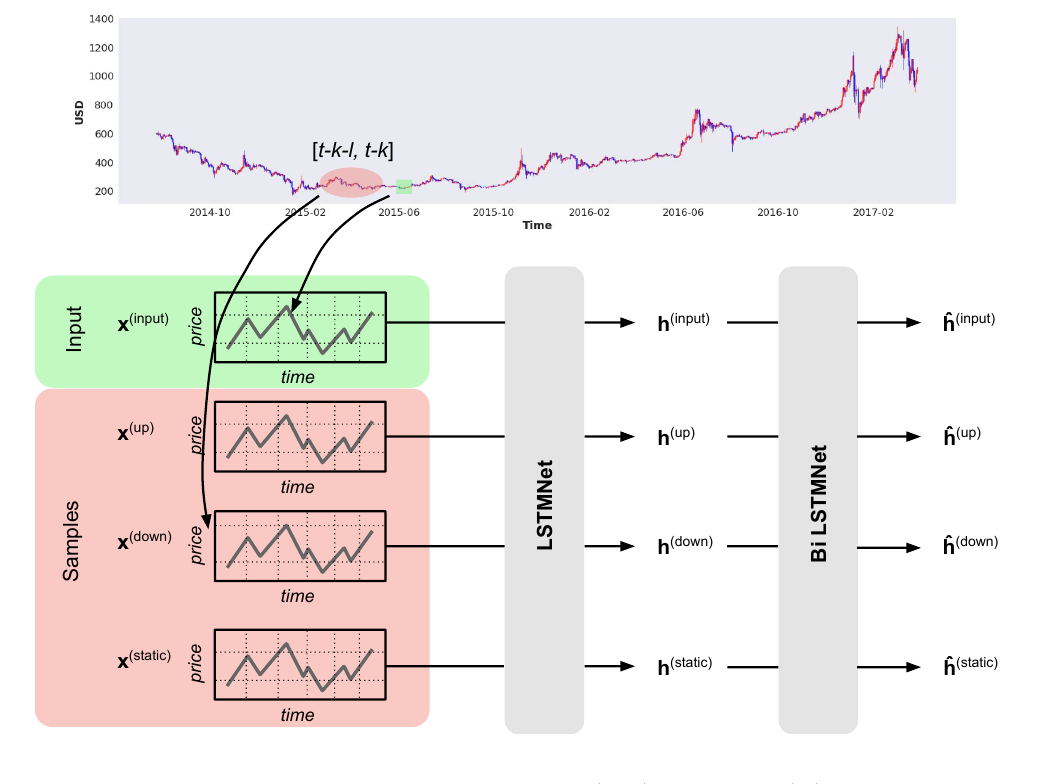
( input ) ( up ) ( down ) ( static ) , sequences x , x , x are t t t t